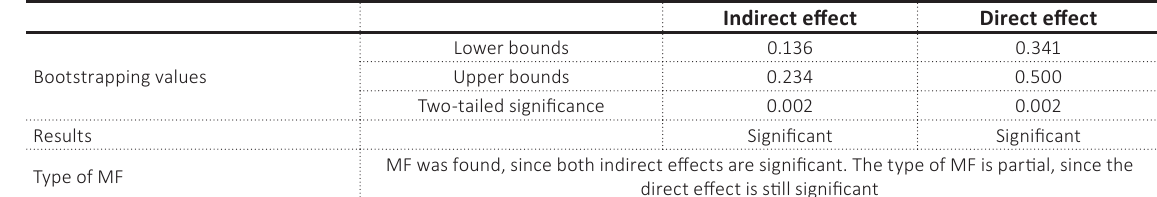
Table 9. Bootstrapping results of the